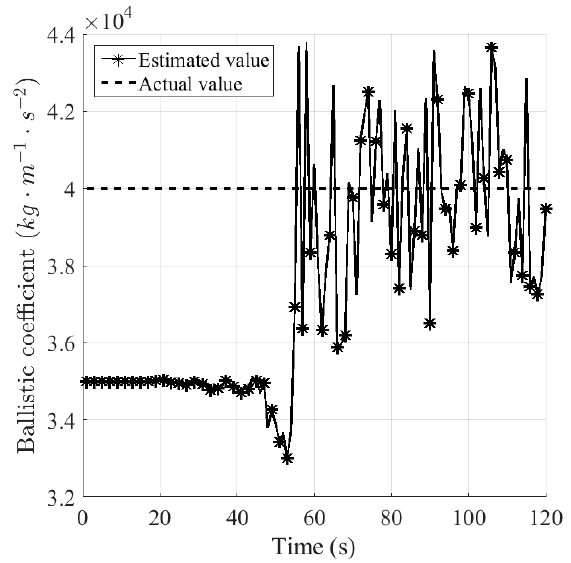
Figure 9. Estimated value of the ballistic coefficient for sensor S 1 .